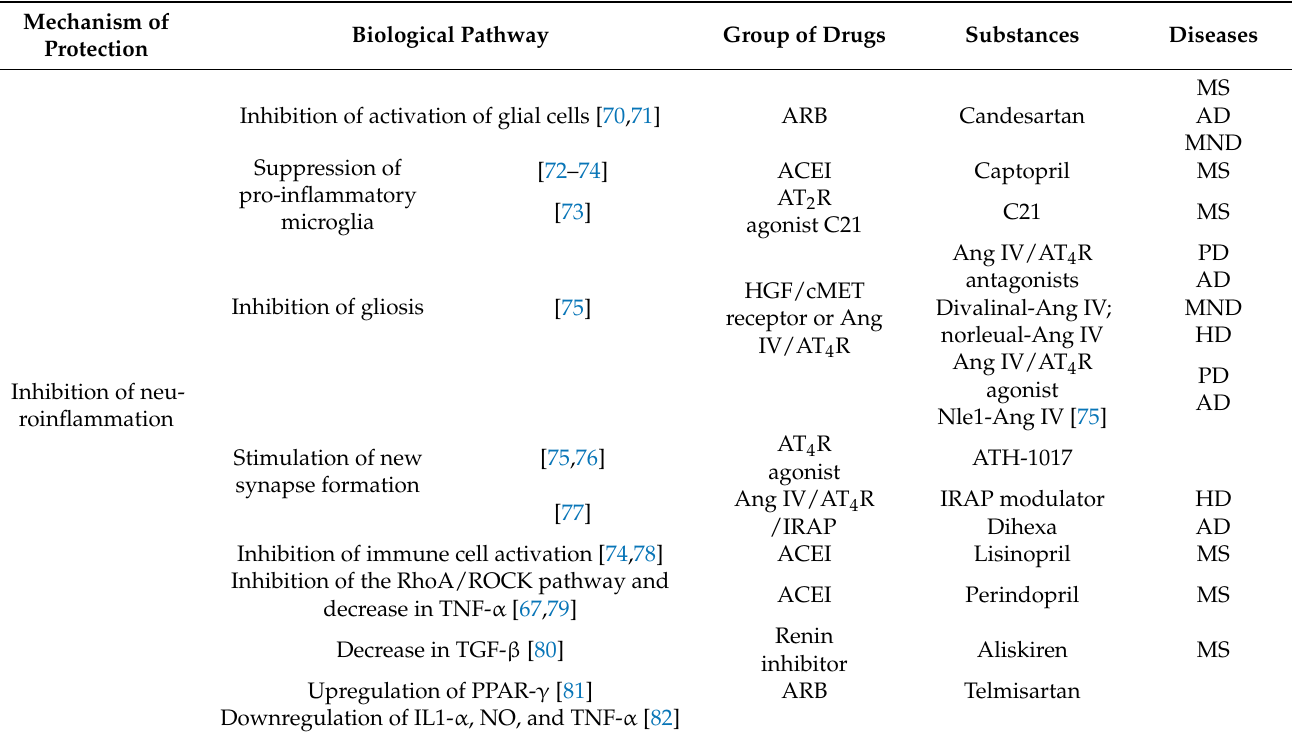
Table 2. Protective mechanisms of RAS pharmacological modulators via the inhibition of neuroin-